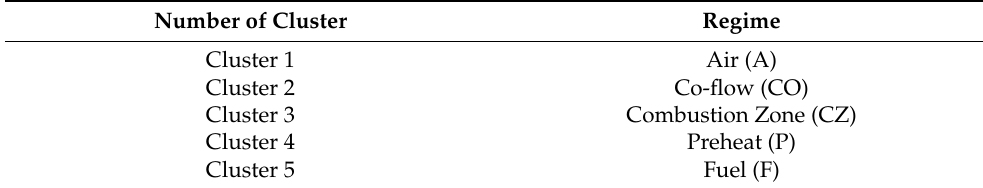
Table 1. Regimes represented by different